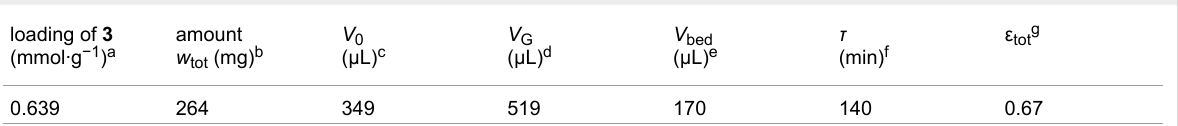
Table 2: Main features of the catalytic